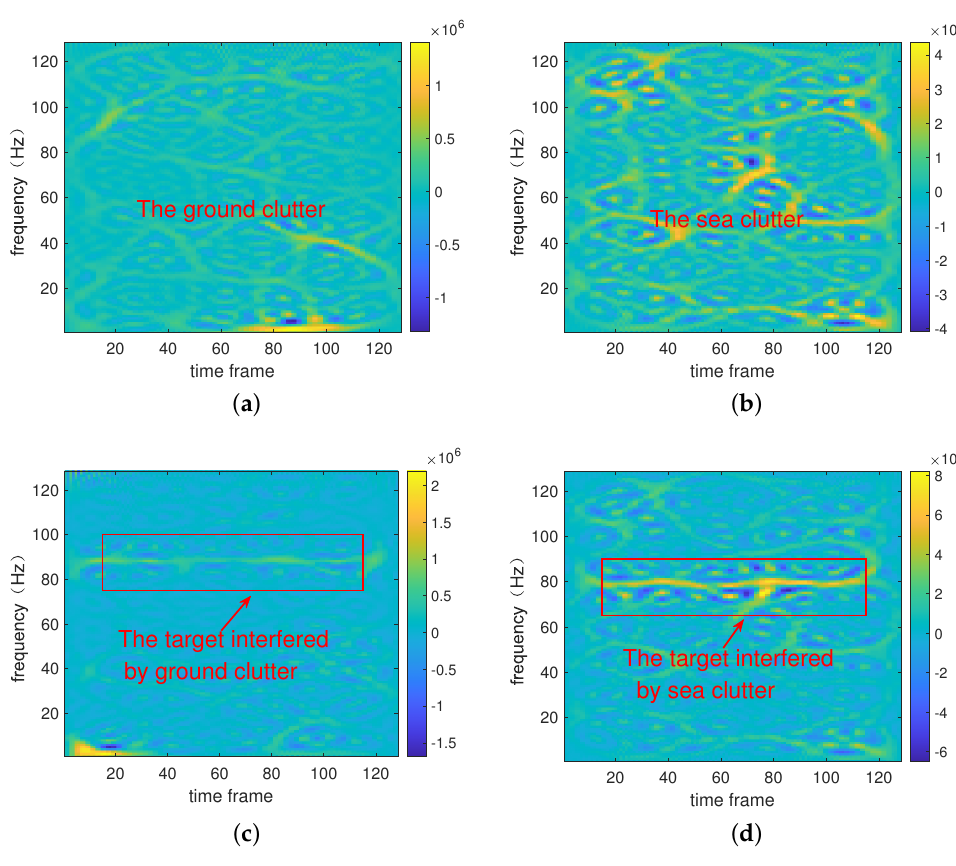
Figure 4. Time-frequency maps. ( a ) SPWVD of ground clutter. ( b ) SPWVD of sea clutter. ( c ) Target SPWVD interfered by ground clutter. ( d ) Target SPWVD interfered by sea